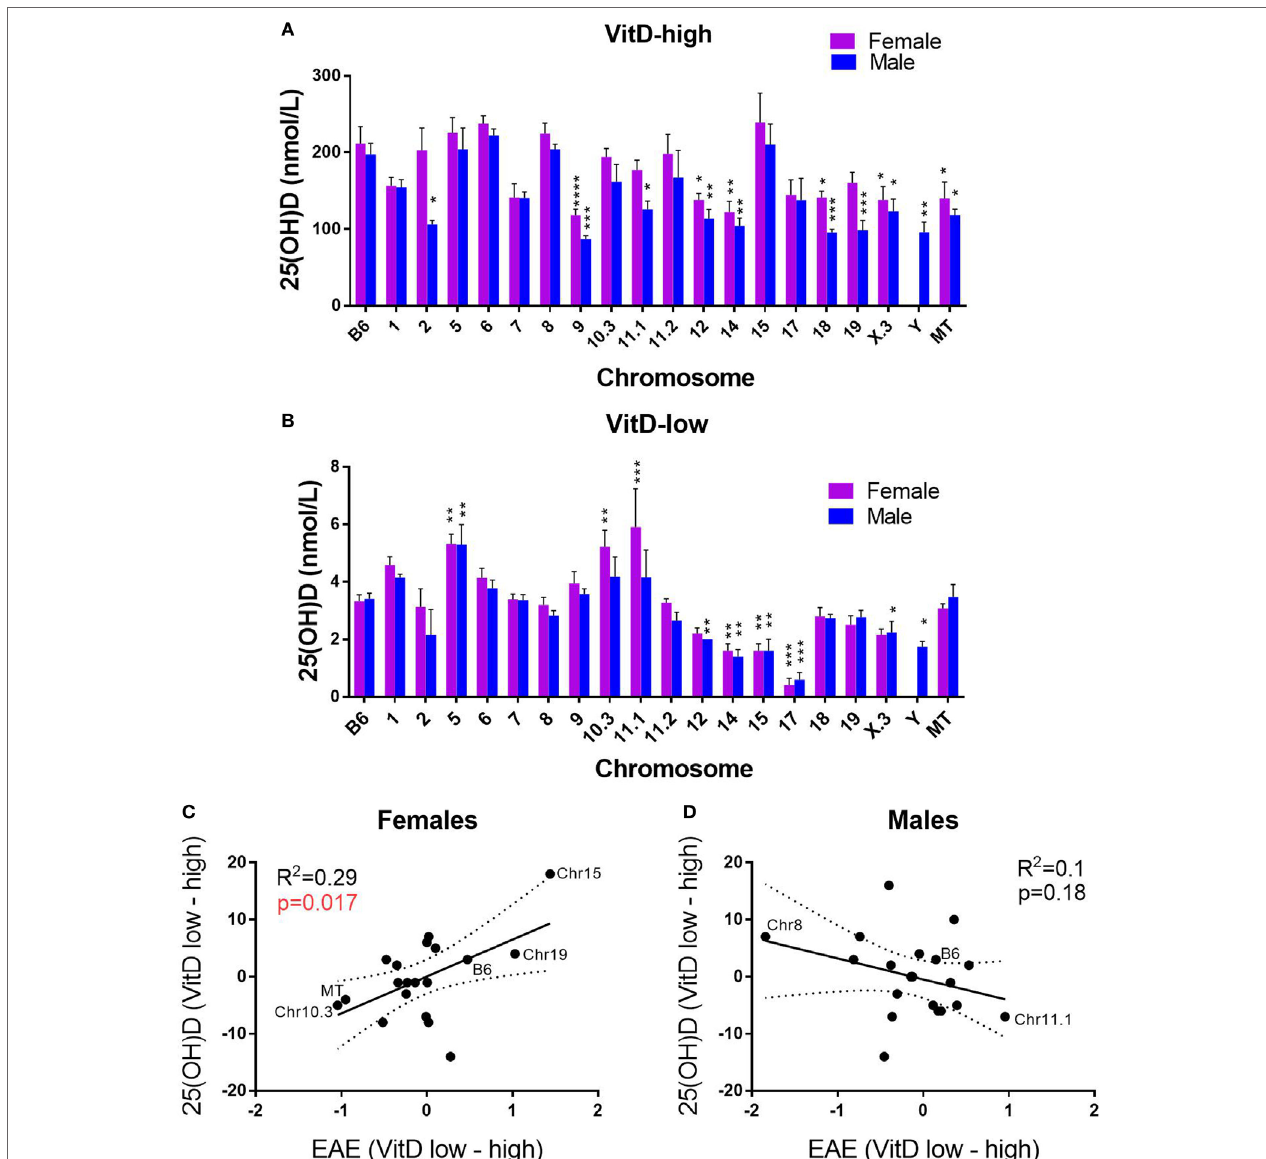
FigUre 5 | Effects of genotype and sex on systemic vitamin D3 (VitD) levels as related to EAE outcomes. B6.Chr PWD consomic mice were exposed to VitD-high (a) and VitD-low (B) diet, followed by EAE induction, as in Figure 4 . Sera were collected at day 30 post-EAE induction. 25(OH)D levels were measured by enzyme-linked immunoassay in five males and five females of each strain for each diet type. The significance of the observed differences was assessed by two-way ANOVA, followed by Holm–Sidak’s post hoc comparisons, comparing each consomic strain to B6. Symbols indicate a significant difference between B6 and the indicated groups, as follows: * p < 0.05; ** p < 0.01; *** p < 0.001; **** p < 0.0001. (c,D) The relationship between serum 25(OH)D levels and EAE severity was examined, as described in Section “Materials and Methods.” Linear regression was used to determine the significance of the correlation between the ranked 25(OH)D response [difference in 25(OH)D between VitD-low and -high diets] and normalized EAE response (difference in cumulative disease score between VitD-low and high diets). R 2 values and p -values for regression analysis are shown. Selected B6.Chr PWD consomic strains are labeled as specific